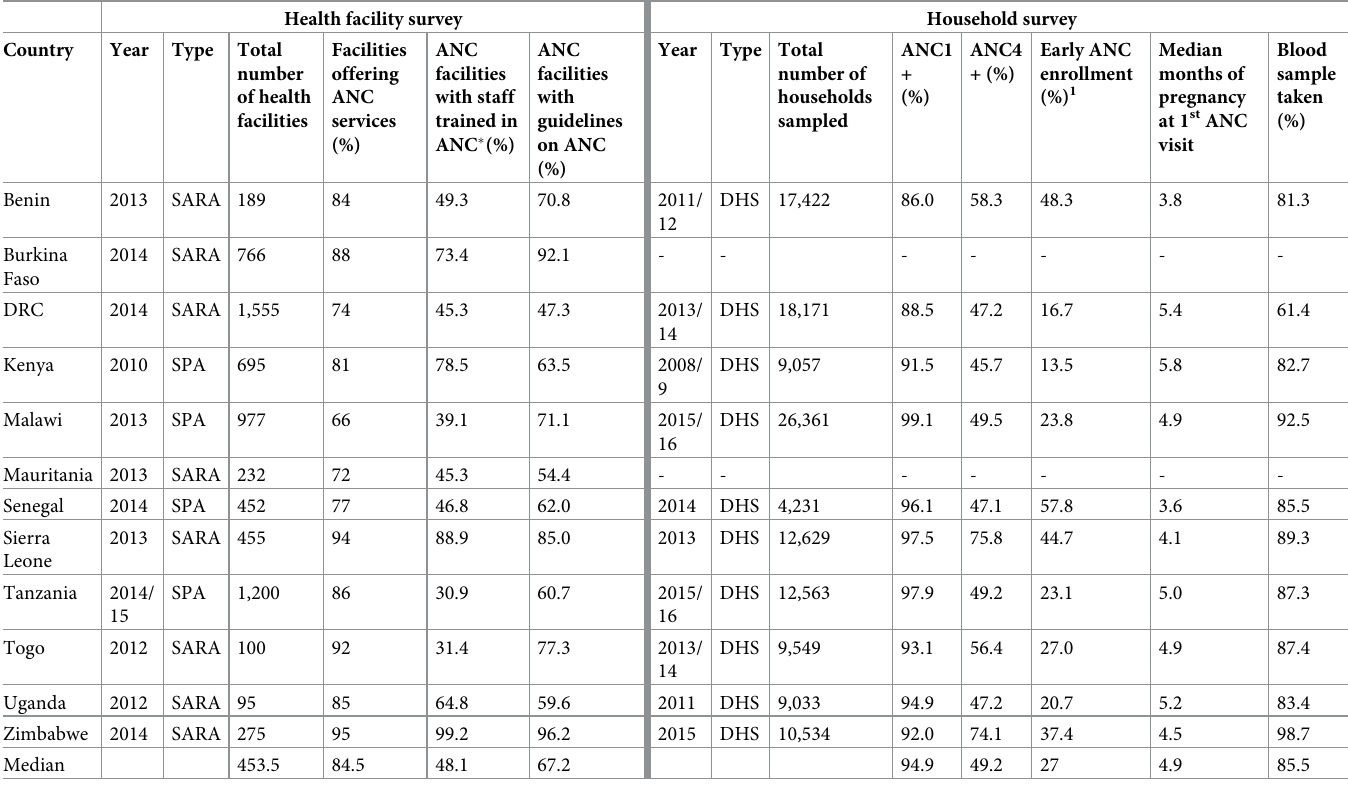
Table 2. Health facility and household surveys